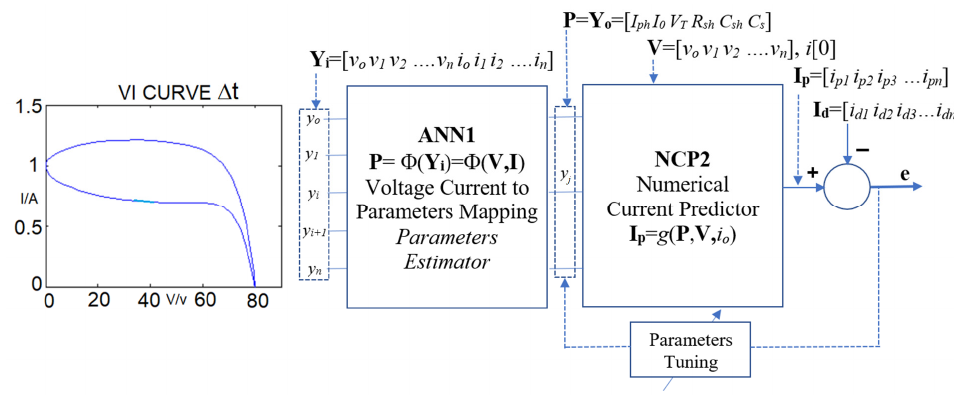
Figure 4 . Block Diagrams of the PV panel parameters estimation system.